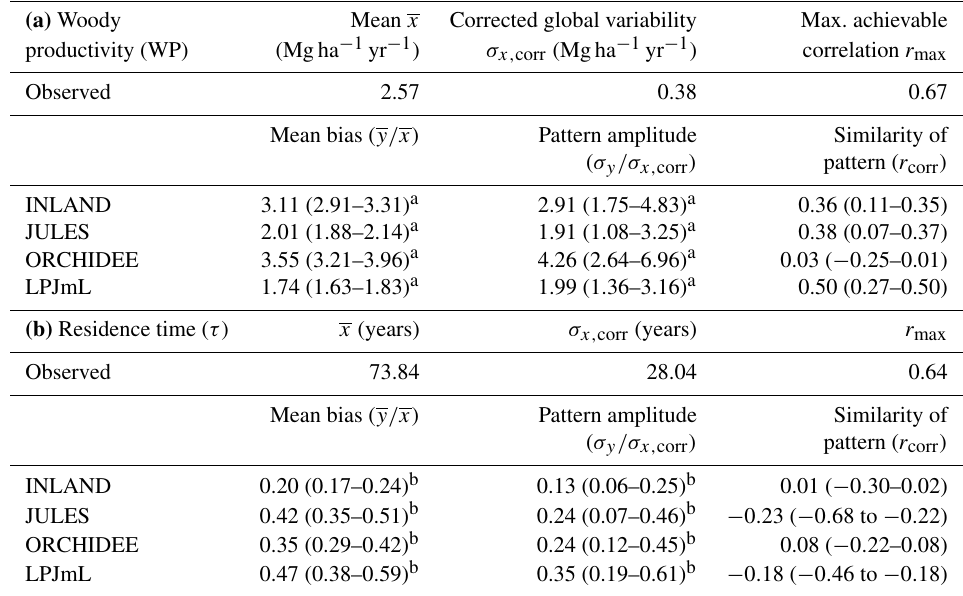
a indicate when models overestimate observed values, b indicate